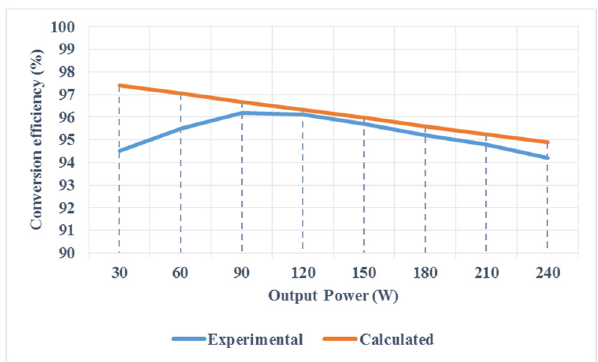
Figure 10. The calculated and experimental efficiency of the converter.